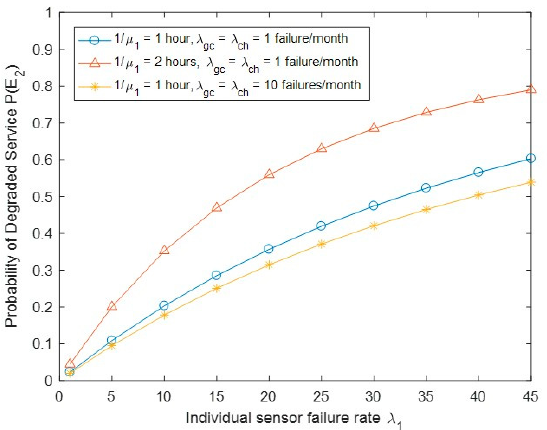
Figure 7. Probability of degraded service P ( E 2 ) vs. biosensor failure rate λ 1 .